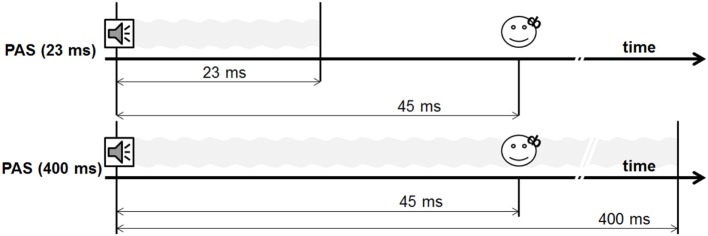
Design experiment 1.